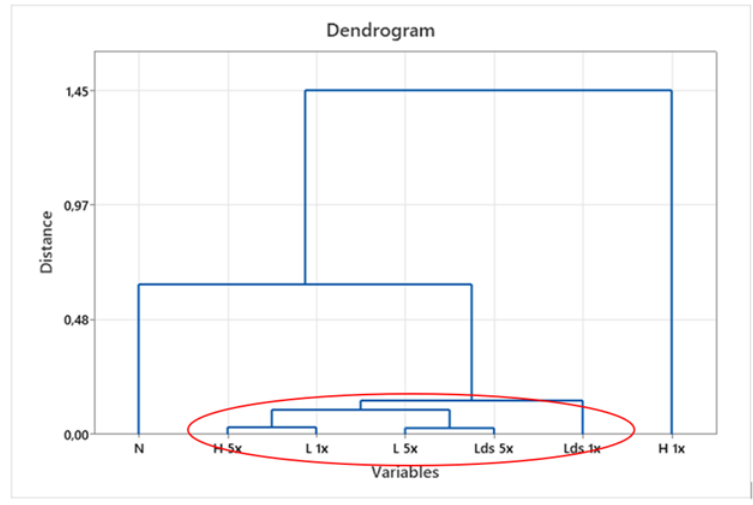
Figure 10. Dendrogram of Euclidean distance for contact angle, air permeability, and whiteness as variables of unwashed and 1 × and 5 × washed samples. Red circle indicates samples with very small distances.